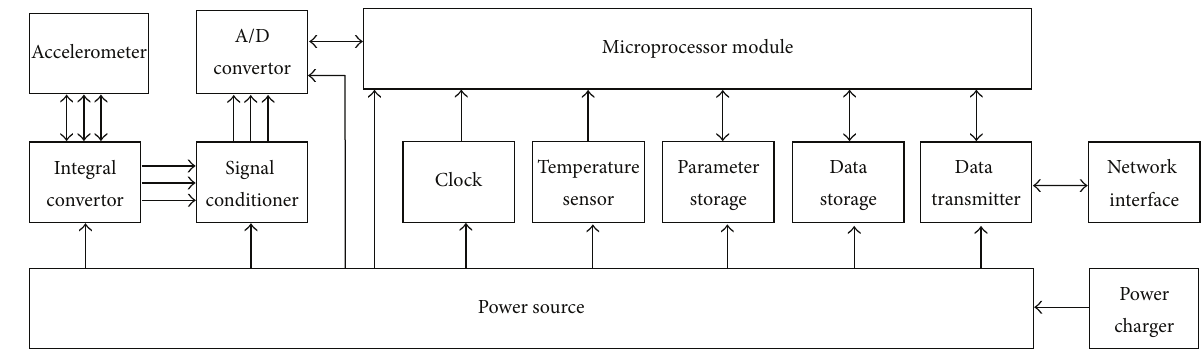
Figure 2: Circuit function